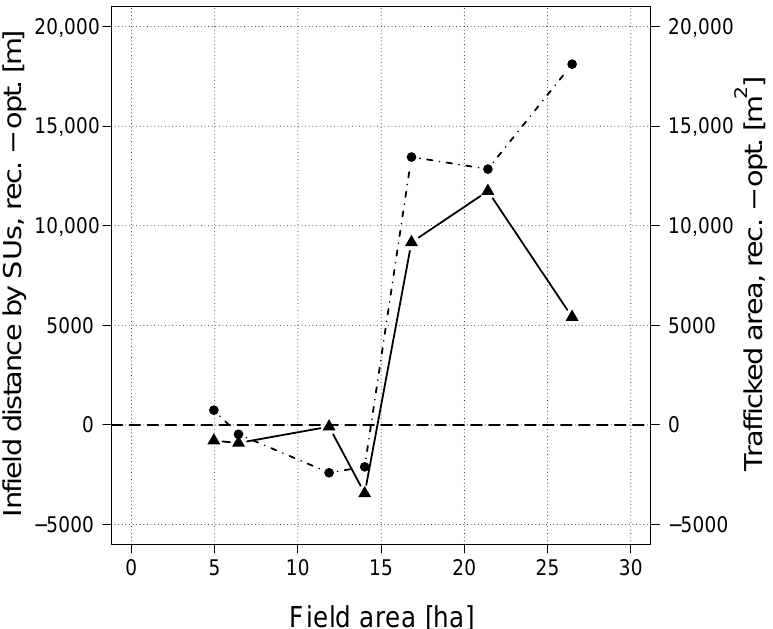
Figure 9. Differences in the total in-field travelled distance of SUs ( (cid:108) ) and the area with traffic ( (cid:115) ) in relation to field size. A difference (y-axis) is calculated per field by subtracting the recorded total travelled in-field distance and the area with traffic derived from the recorded data from the total travelled in-field distance and the area with traffic derived from the simulated optimised route plan data, respectively. The dashed horizontal line at zero on the y-axis indicates whether the optimised route planning provided an increase or decrease in the total travelled in-field distance of SUs or the area with traffic compared to the results from recorded data, indicated by negative or positive in-field distances, respectively, in the figure. Note that the scale on both y axes are identical, but with different